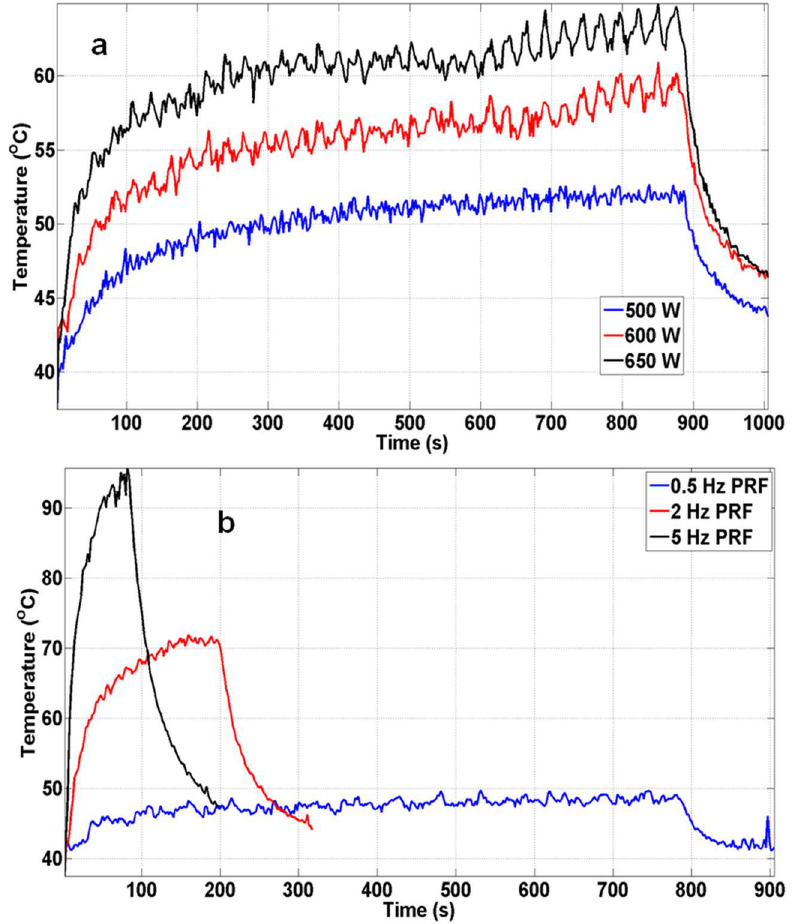
600, and 650 W of acoustic power. All three power settings produced similar exponential temperature increaseand decrease, with different peak temperatures. b . Temperature curves obtainedwhile sonicatingat 0.5, 2, and 5 Hz PRF. The peak temperatures obtained were 50˚C, 72˚C, and 95˚C for PRF of 0.5, 2, and 5 Hz,